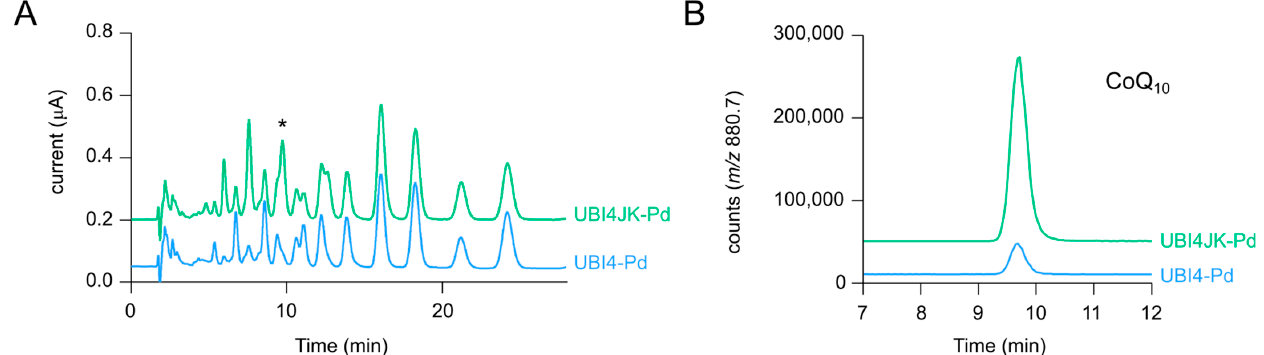
Figure 3. ( A ) Overlay of ECD chromatograms from extracts of strains UBI4-Pd and UBI4JK-Pd. * indicates the peak corresponding to CoQ 10 . ( B ) Overlay of SIM chromatograms for CoQ 10 (NH 4+ adduct m/z = 880.7). Chromatograms are representative of three independent samples.